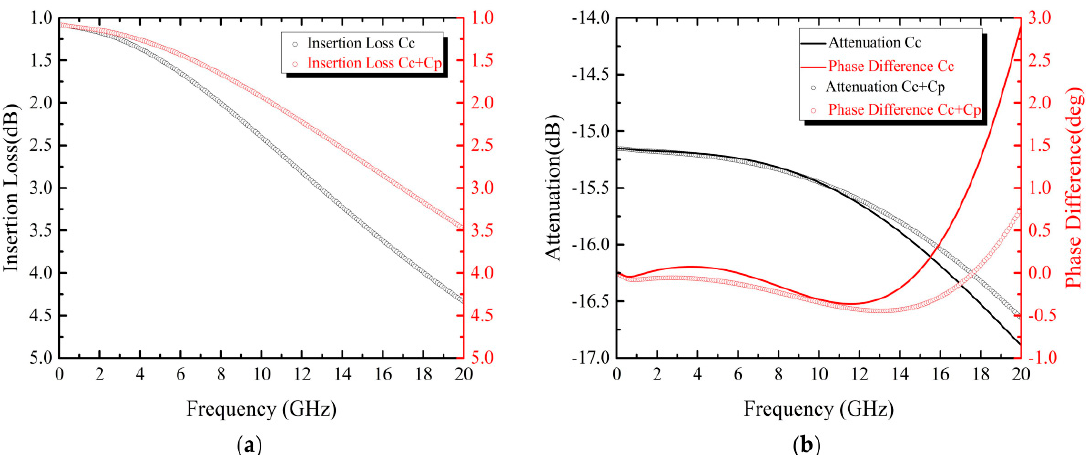
Figure 7. ( a ) The simulation insertion loss results with traditional C c and proposed C c + C p compensation in 16 dB attenuation cell; ( b ) the simulation attenuation, phase difference results with traditional C c and proposed C c + C p compensation in 16 dB attenuation cell.